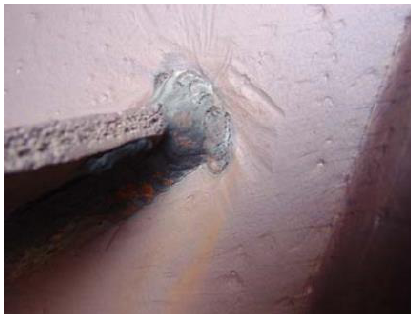
Figure 22. Photo of the crack on B fan.